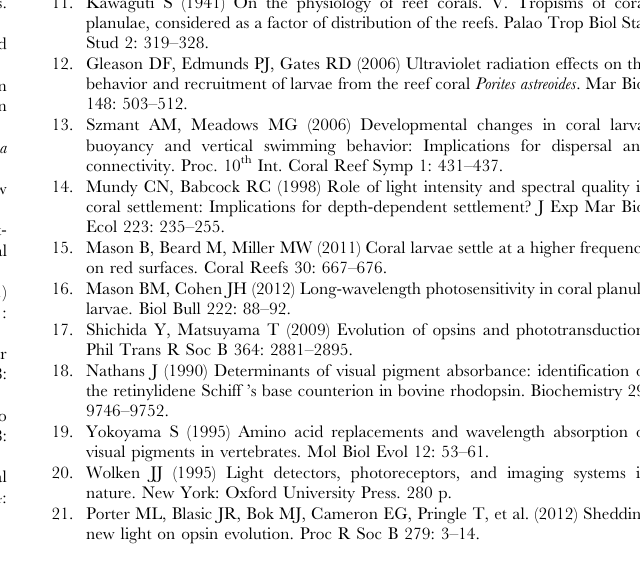
Figure S2 Localization of acropsin 2 in epithelial cells of Acropora palmata larvae. Immunofluorescent confocal image of a section showing morphology of acropsin 2-positive epithelial cells. Cell nuclei stained by DAPI are shown in blue, green represents endogenous GFP fluorescence, and red shows labeling by anti-acropsin 2 primary and Cy3-labeled secondary antibody. Objective =63 6 oil; scale bar= 10 m